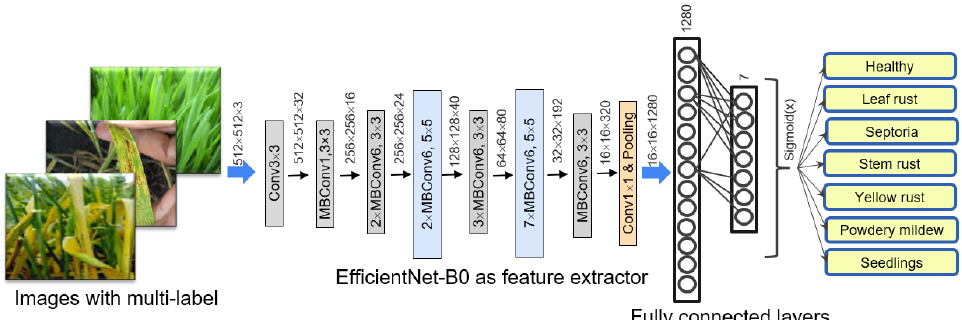
Figure 3. Diagram of the neural network used to predict fungal diseases of wheat. Table 2. Parameters of the EfficientNet-B0 network used in our